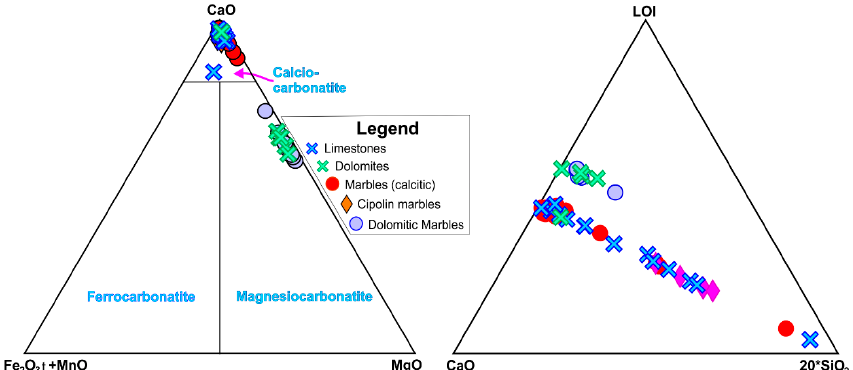
Figure 4. Ternary discrimination diagram of carbonated samples in the fields of calciocarbonatite, ferrocarbonatite and magnesiocarbonatite (left). Ternary CaO–20*SiO 2 –LOI diagram depicting the relationship between the SiO 2 content and the CaO/LOI ratio (right). Green square: limestone, pink circle: marble; blue triangle: dolomite. (after Woolley and Kempe, 1989 [31]). In particular, calcitic marbles present high CaO and low MgO contents (49.86–55.85 wt.% and